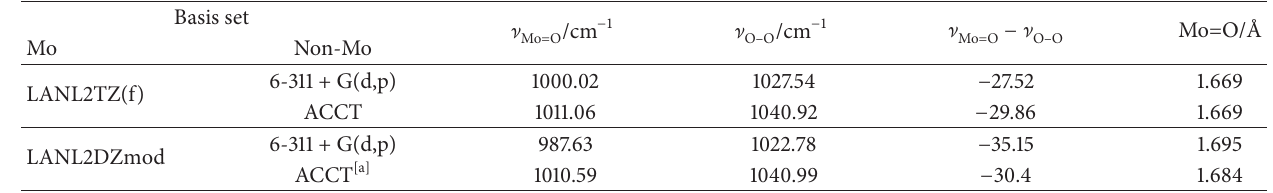
Table 3: Results at M06 with various basis sets as indicated in the table.